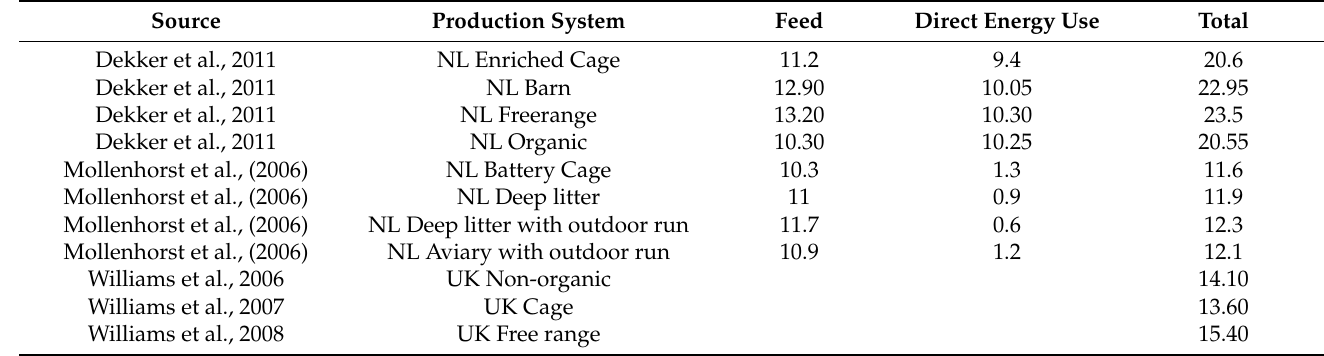
Table A5. Energy inputs for egg-producing systems MJ/kg (based on